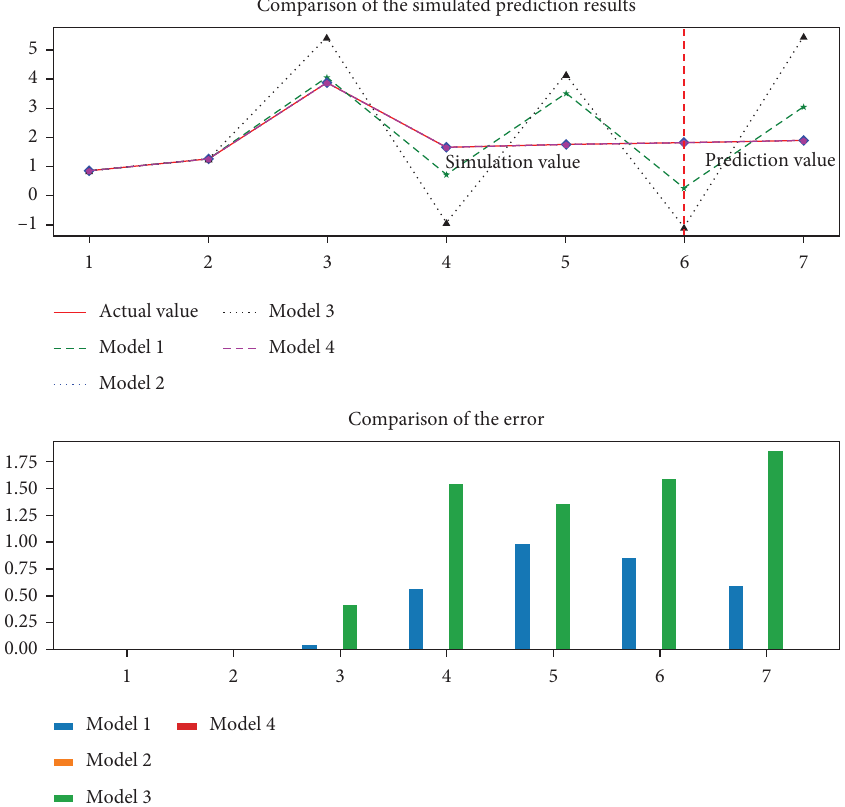
Figure 4: Schematic diagram of the predicted results for stochastic oscillation sequence X